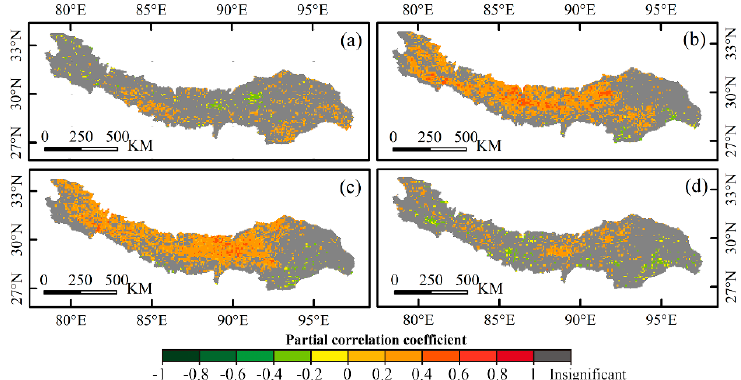
Figure 8. Spatial patterns of partial correlation coefficients between summer NDVI and four climatic factors: temperature ( a ), precipitation ( b ), downward long-wave radiation ( c ), and downward short-wave radiation ( d ).